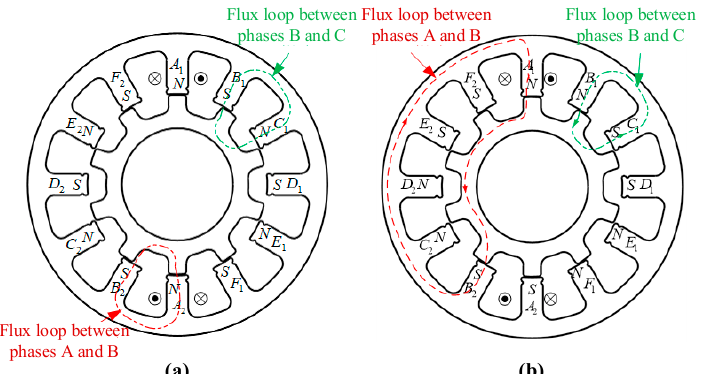
Table 1. Main parameters of six-phase SRM.